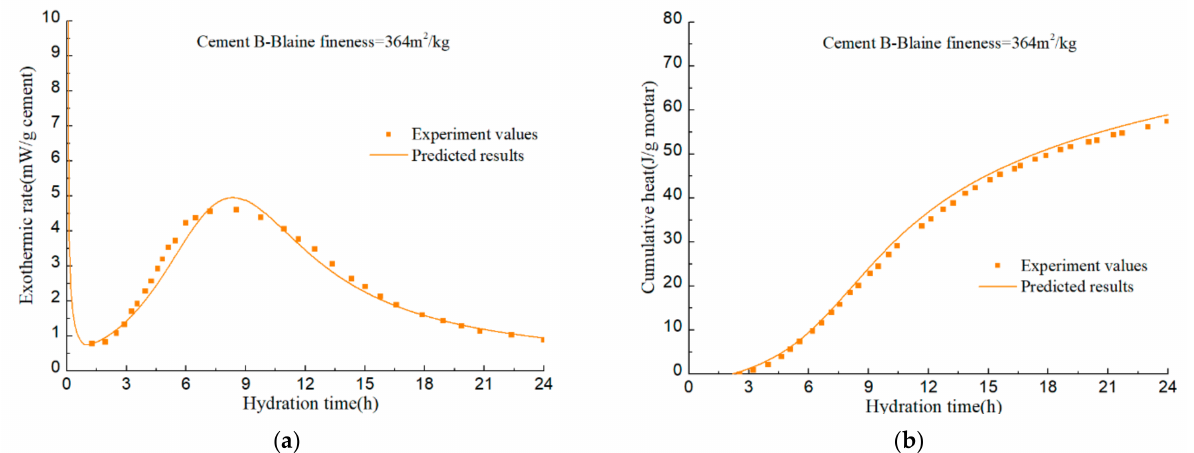
Figure 23. Isothermal calorimetry test values and model prediction results of Cement II: ( a ) hydration heat release rate per unit mass of cement; ( b ) cumulative hydration heat of per unit mass of mortar.